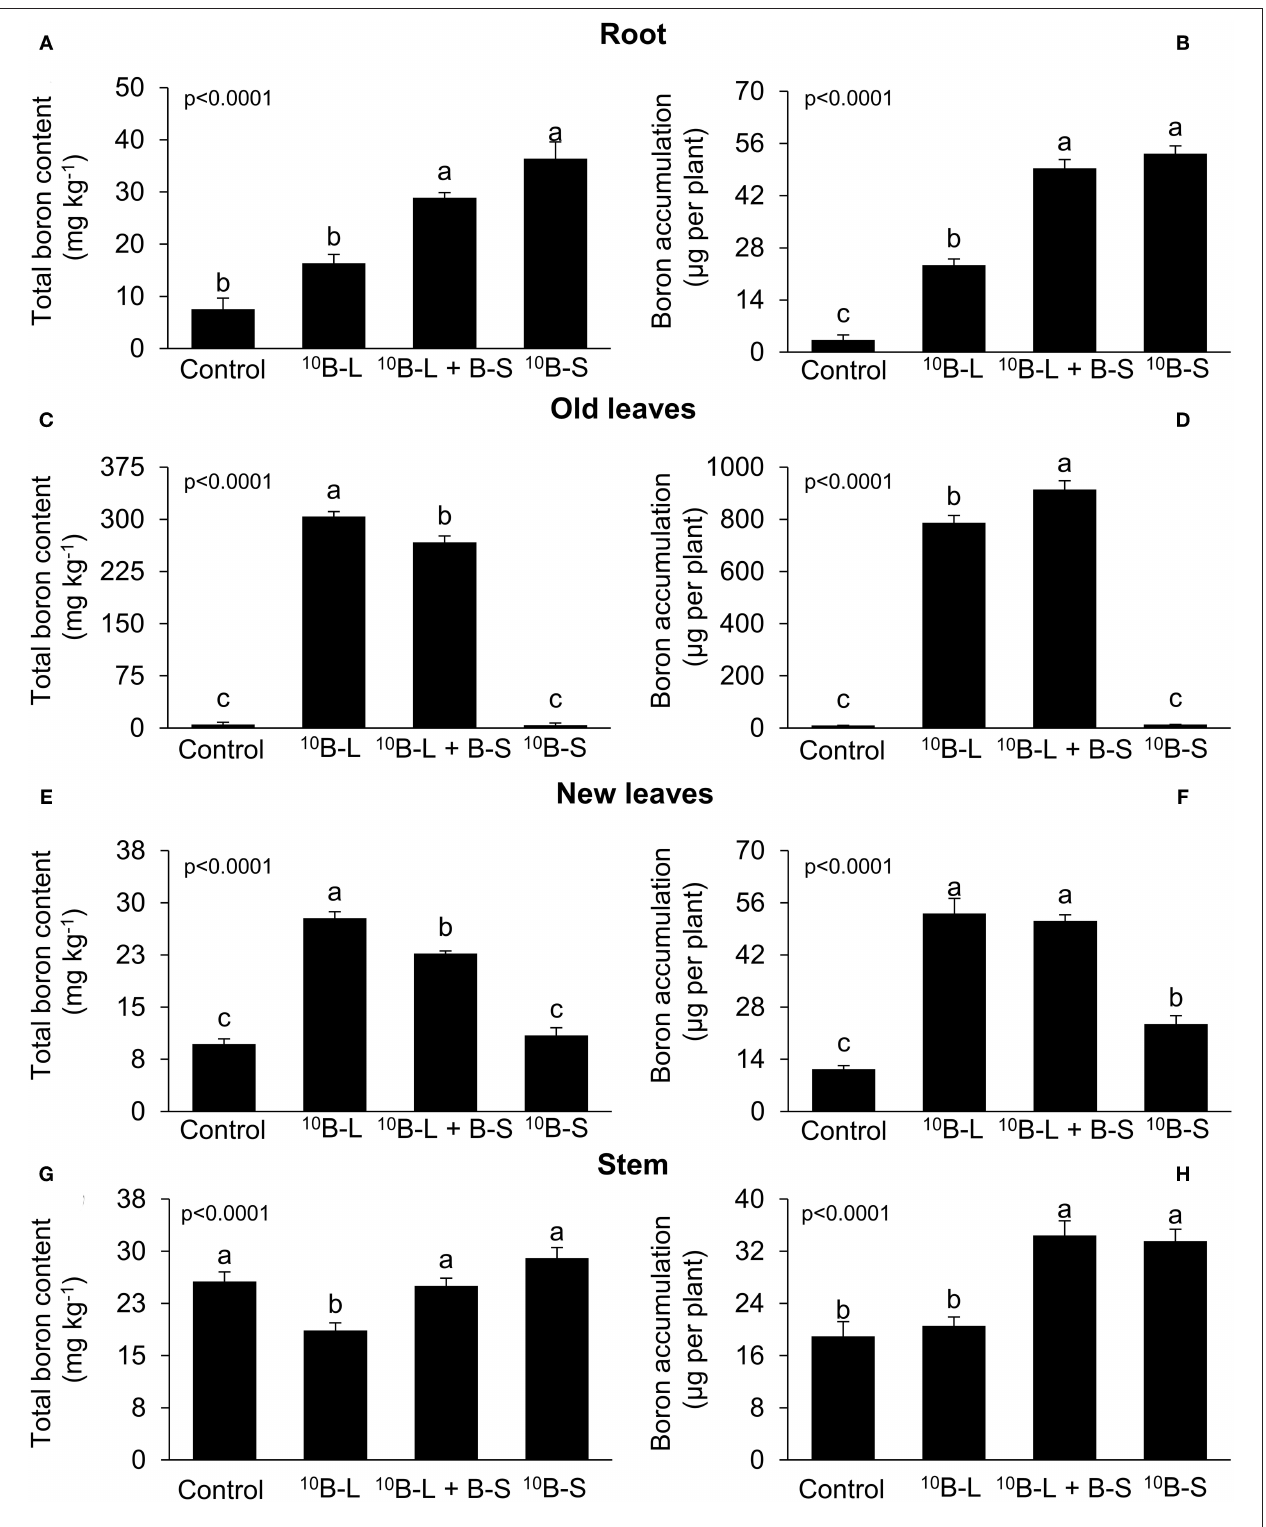
FIGURE 2 | Boron concentration and accumulation on the roots (A,B) , old leaves (pulverized part) (C,D) , new leaves (E,F) , and stems (G,H) in the function of the application of marked ( 10 B) and unmarked B forms of the element. Control, no B fertilization in the leaf/the foliage and substrate (growth media); 10 B-L, without B on the substrate (growth media) and with 10 B via leaf; 10 B-L + B-S, fertilization with B on the substrate (growth media) and 10 B via the leaf/the foliage; 10 B-S, fertilization with 10 B on the substrate (growth media) and without fertilization with B via leaf. Bars represent the standard errors of means. Lowercase letters indicate significant differences among treatments, according to Tukey’s test at a 5% probability level. Values are presented as mean ± SE.